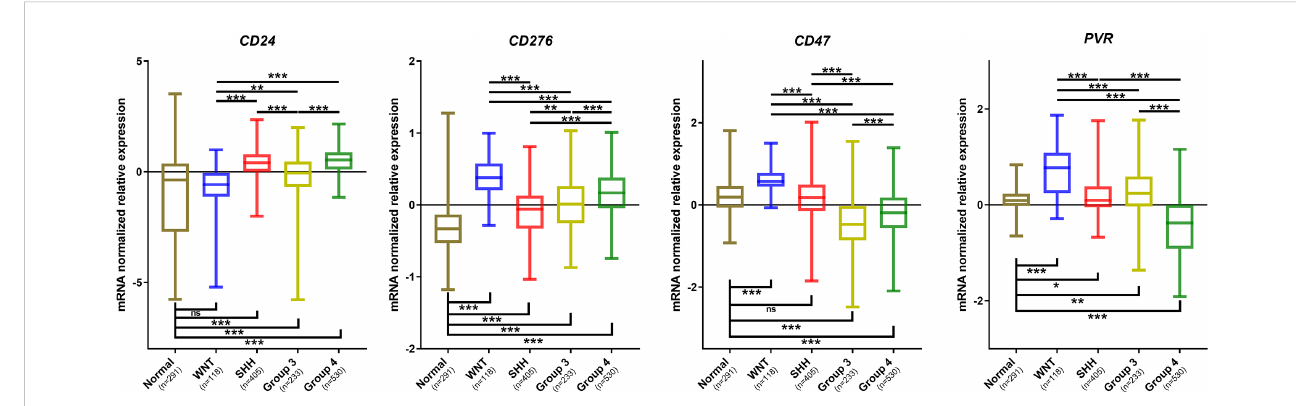
FIGURE 7 Graphic representation of CD24 , CD276 , CD47 , and PVR mRNA normalized mRNA levels obtained from the analysis of the Batch dataset. The signi fi cance level is 0.05. * < 0.05; ** < 0.01; *** < 0.001. The plots were obtained through GraphPad Prism 8. ns, non signi fi cant.